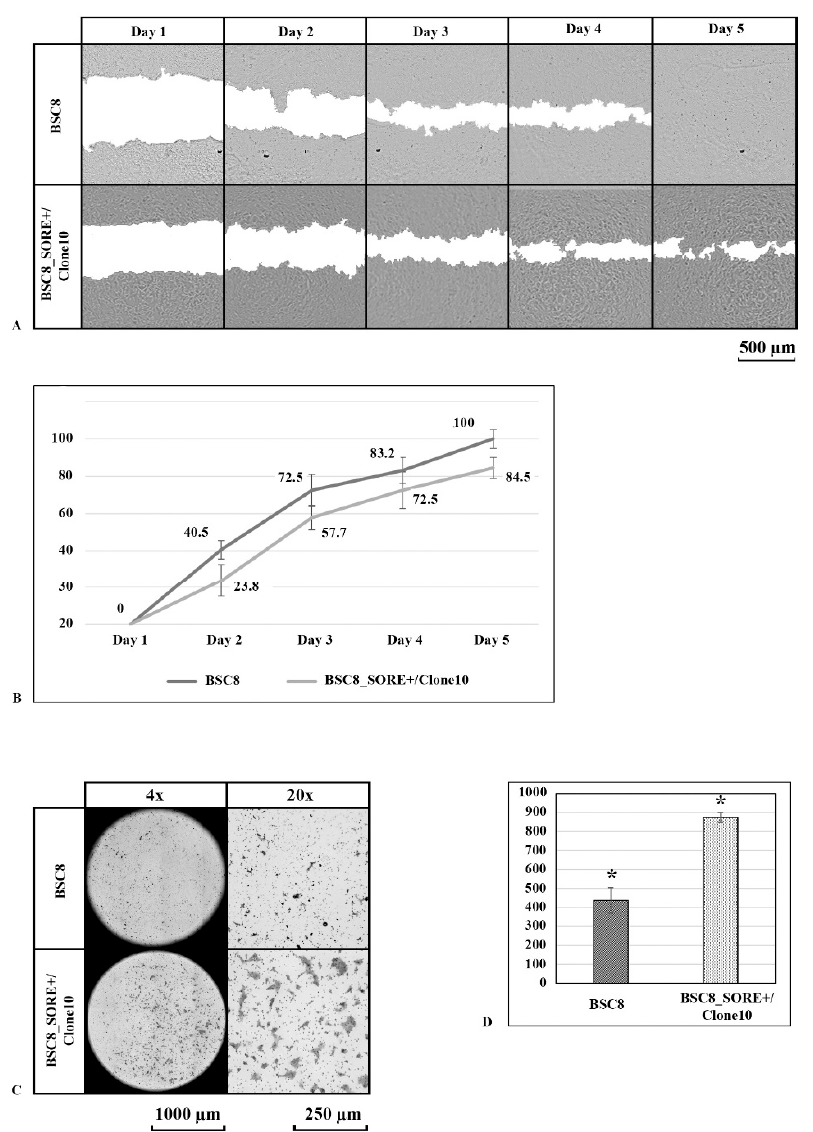
Figure 4. Comparison of the migratory activity of the “stem-like” BSC8_SORE+ cells and original BSC8 cells. ( A ). The growth of the SORE+ and original BSC8 cells during the “wound repair” test (original magnification 4 × ). ( B ). The intensity of wound healing by the SORE+ and original BSC8 cells. Complete closure (overgrowing) of the cell-free surface occurred on average after five days. A slight decrease in the migratory activity of the BSC8_SORE+ cells is observed. ( C ). Representative images from a Boyden chamber motility assay (original magnification 20 × ). ( D ). Quantitative analysis reflected the accelerated migration of the BSC8_SORE+ cells comparing with original BSC8 cells (437 ± 66.5 and 874 ± 25.5 clones per well, respectively; * p < 0.001). The results are averages with standard errors ( n = 3 for each